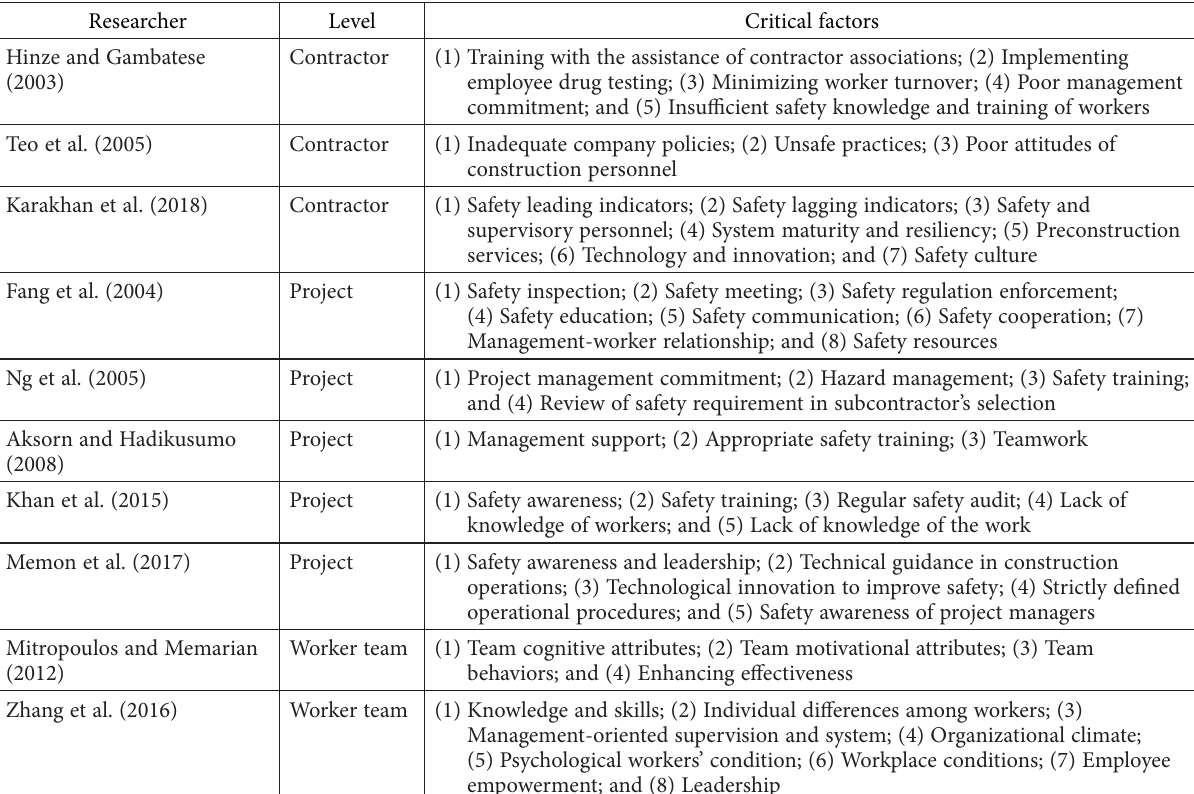
Table 1. Researches on critical factors identification of construction safety